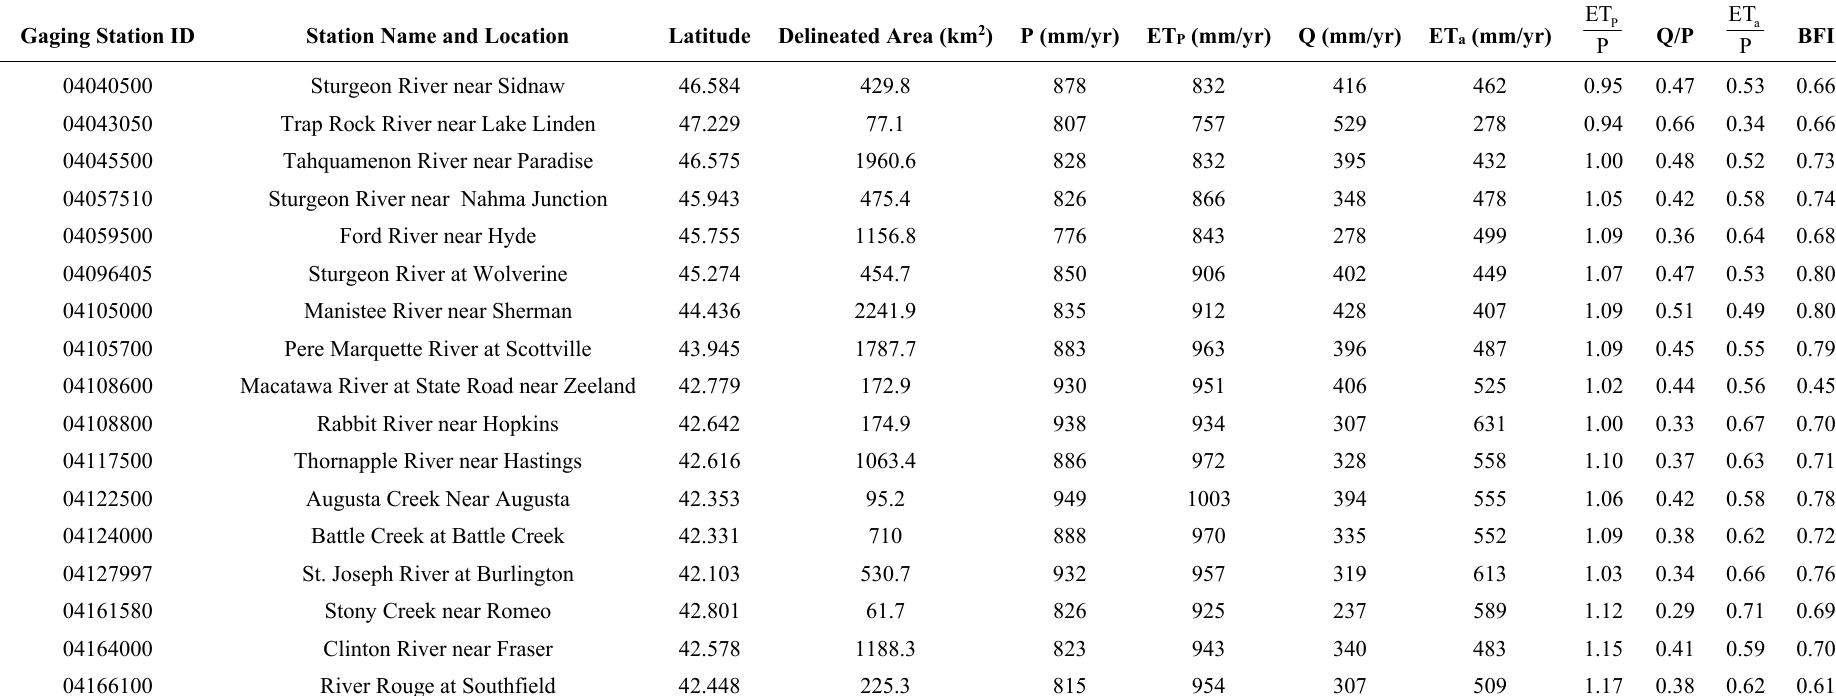
Table 1. Gaging stations and water balance components of seventeen watersheds in